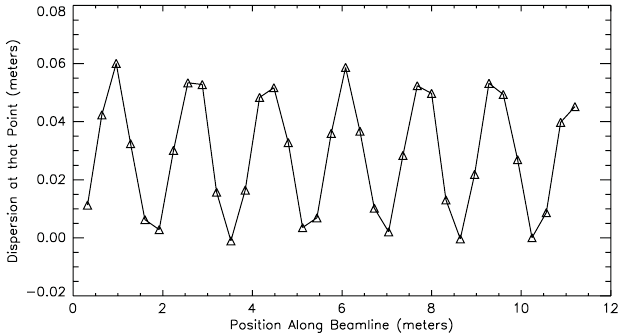
FIG. 6. A plot of the progression of the dispersion as the one term map is generated FODO section by FODO